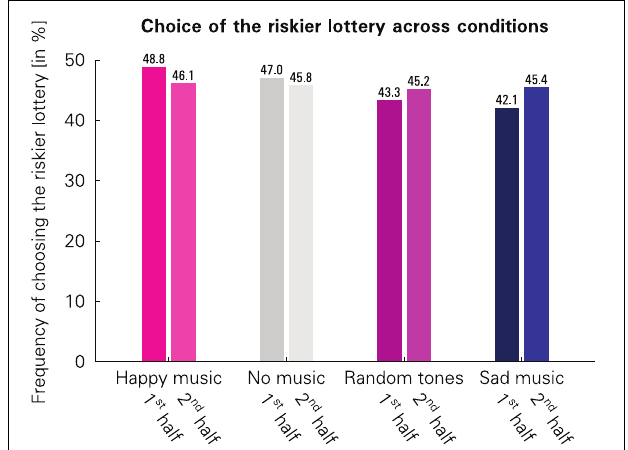
FIGURE 3 | Comparison of the frequencies with which the riskier lottery was chosen across the four conditions in the first 25 trials of a block following musical stimulation (1st half) and in the remaining 25 trials of a block (2nd half). (Please note that this chart is shown only for illustrative purposes and is not used for statistical inference, because the statistical analysis needs to account for both between-subject and within-subject variation; see the description of LPM 1 and LPM 2 in the “Materials and methods” section.)